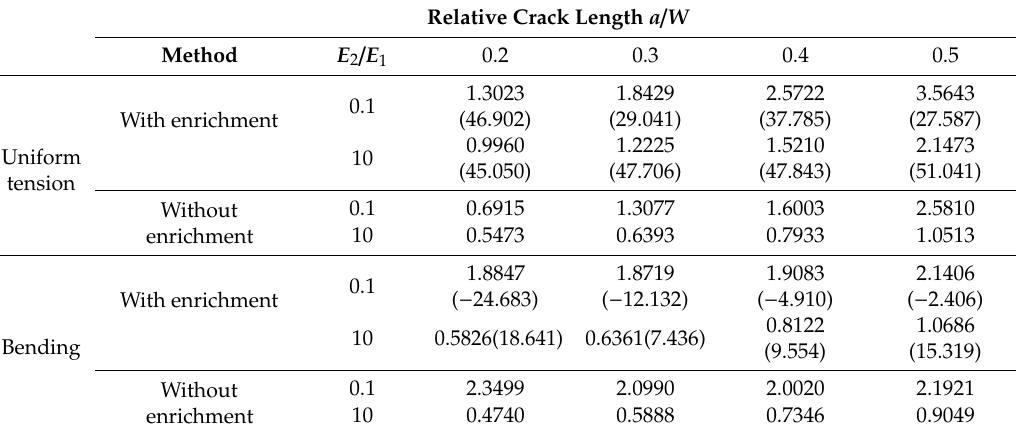
Table 2. Comparison of K I / σ yy